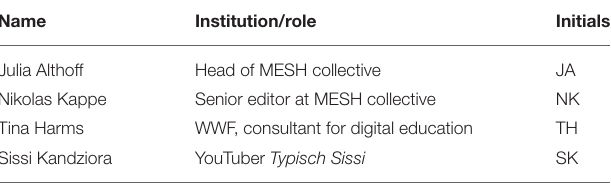
TABLE 2 | Overview on the interviewees for the production